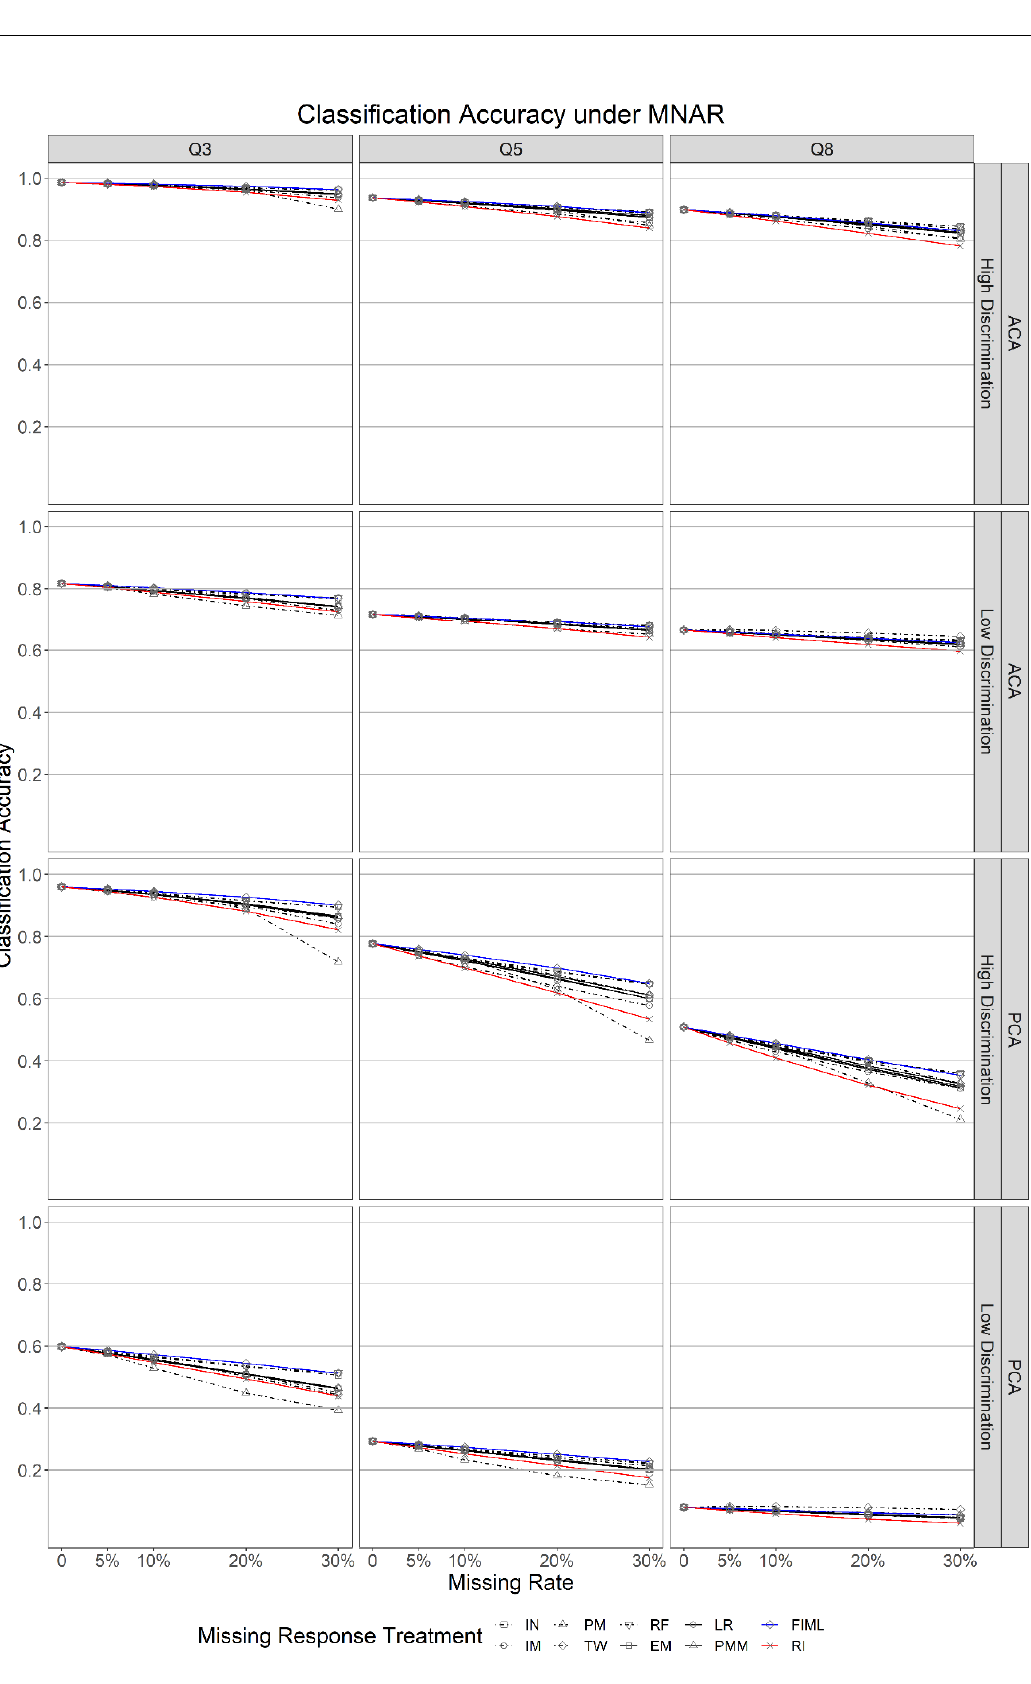
Figure 5. Classification accuracy under the MNAR mechanism. Columns Q3, Q5, and Q8 present results for Q-matrices with three, five, and eight attributes, respectively, while rows refer to results across high and low discriminations for both guessing and slipping parameters.